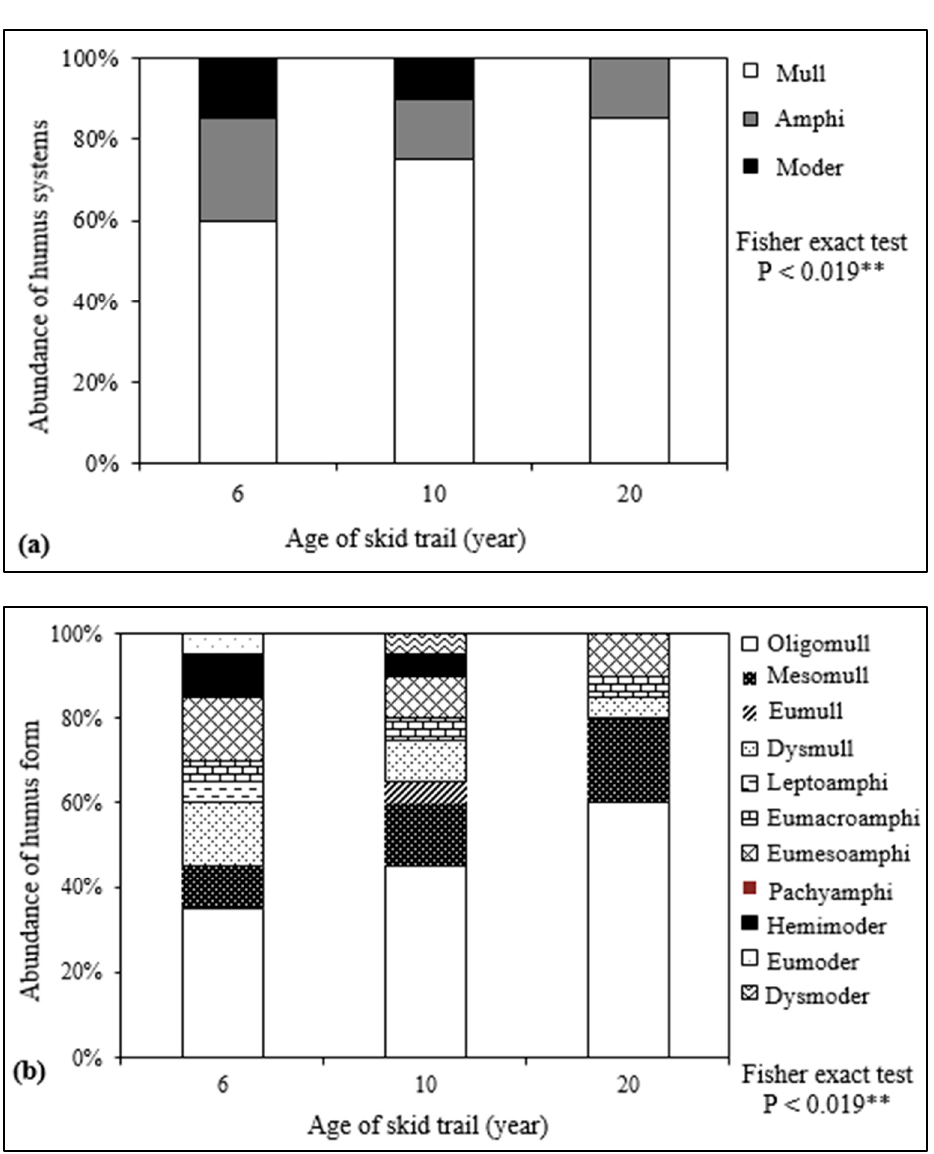
Figure 4. Abundance of humus systems ( a ) and humus forms ( b ) in relation to the age of the skid trail.